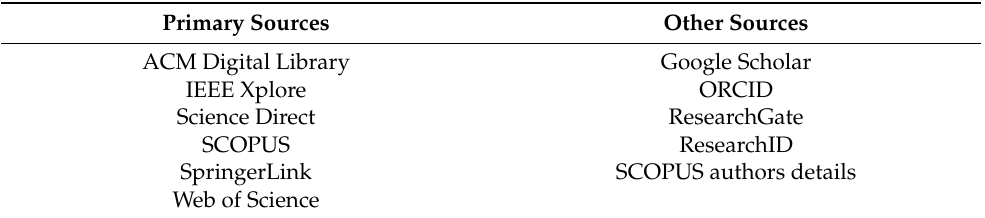
Table 4. Publication sources.